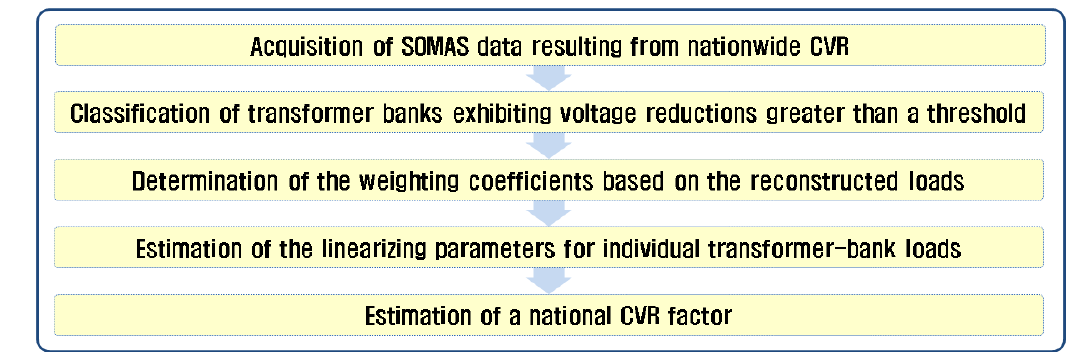
Figure 1 . Flowchart for evaluating the effects of nationwide CVR.